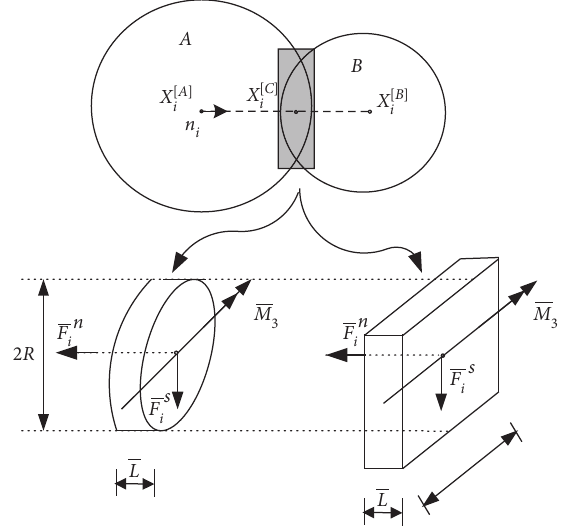
Figure 1: Parallel bond models